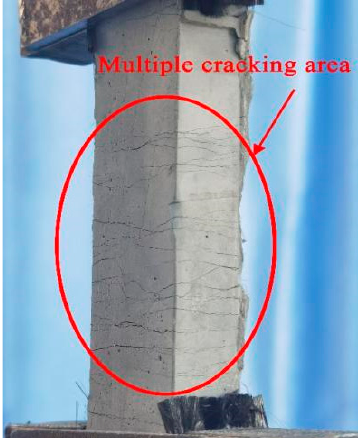
Figure 2. ECC dumbbell-shaped tensile specimen.